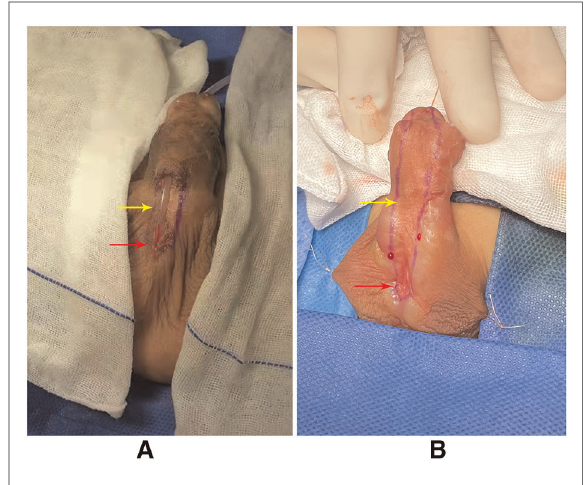
FIGURE 2 ( A ) Appearance 6 months after the fi rst stage of TIP urethroplasty (red arrow: the ectopic urethral ori fi ce; yellow arrow: residual urethral defect). ( B ) Appearance 6 months after the fi rst stage of Byars ’ two-stage urethroplasty (red arrow: ectopic urethral ori fi ce; yellow arrow: residual urethral defect).